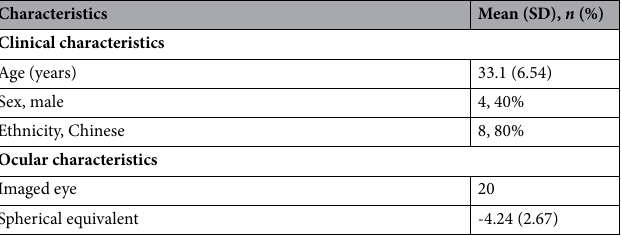
Table 1. Clinical and ocular characteristics of participants ( N = 10 participants). SD standard